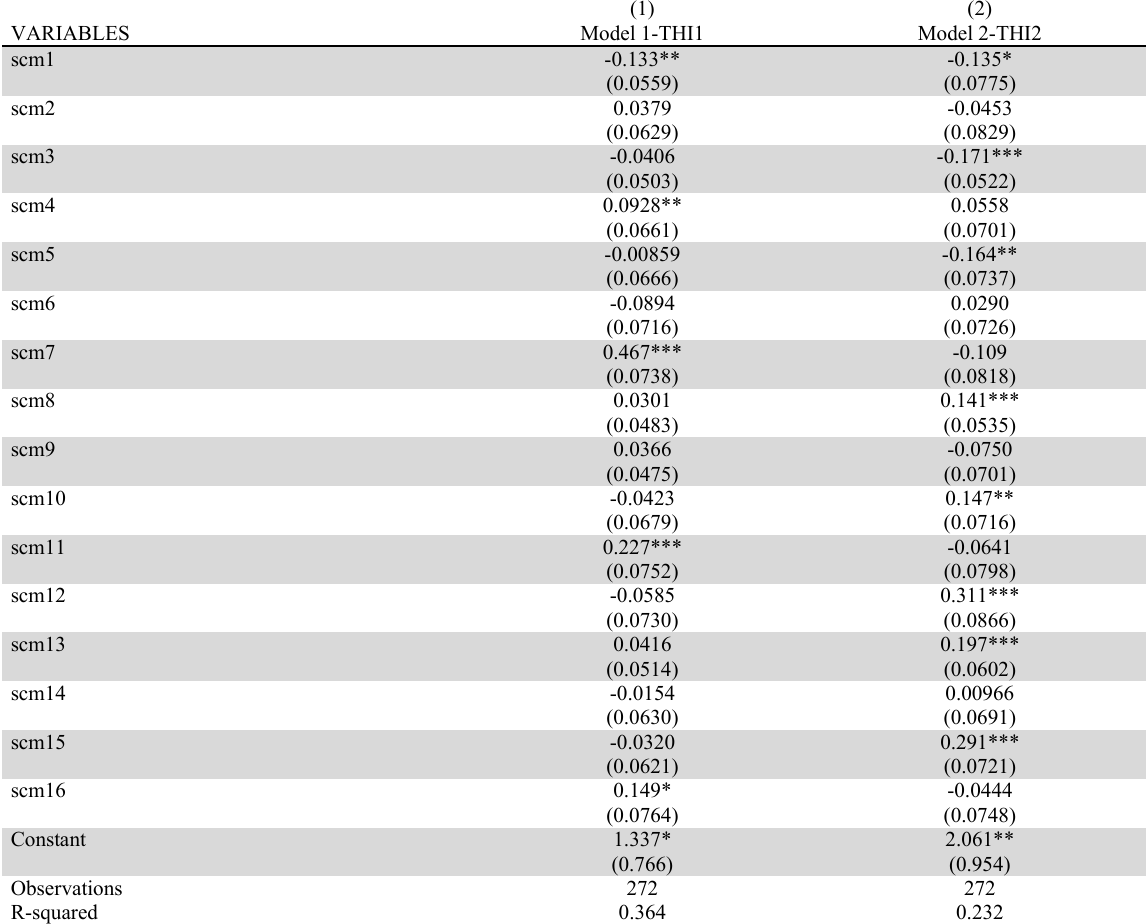
Table 2 Regression Coefficients and Standard error for Model 1 and Model